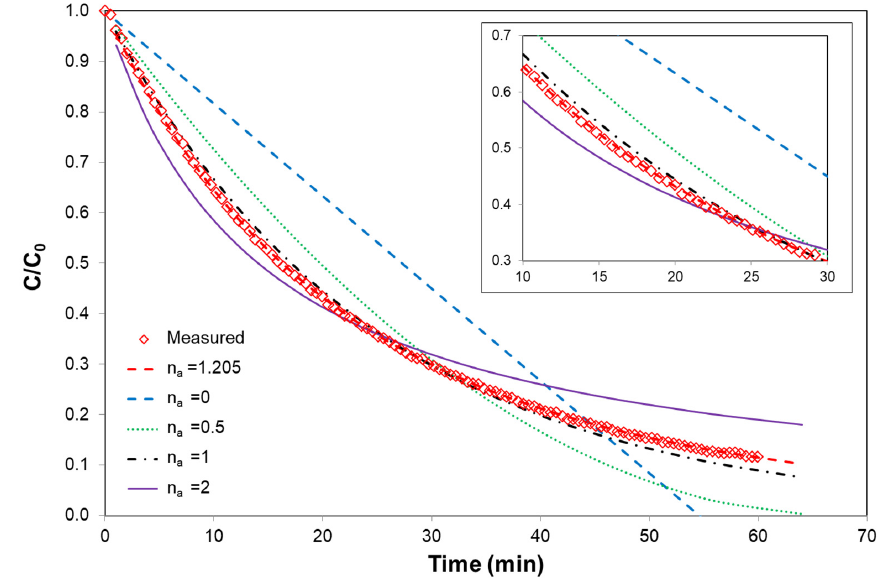
Figure 5. Photocatalytic degradation of 20 µ M ofloxacin in the presence of 2 mg L − 1 H 2 O 2 and TiO 2 . Red squares represent measured values, whereas lines represent different calculated amounts using Equations (2) and (3) and optimized kinetic coefficient parameters (see Table 1). Inset emphasizes fits and differences close to t 1/2 = 16.3 min.